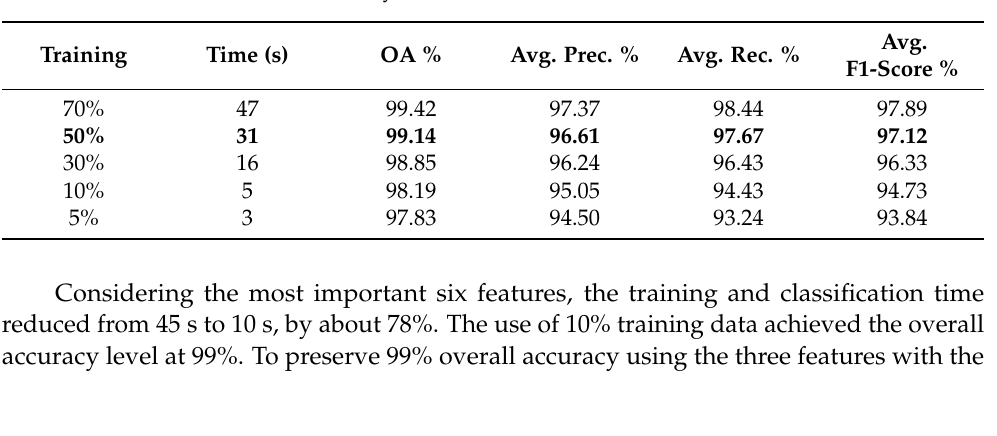
Table 7. Comparison of different sizes of training dataset using three features ( NH , dZ , P λ ). Bold values are close to 99% overall accuracy.